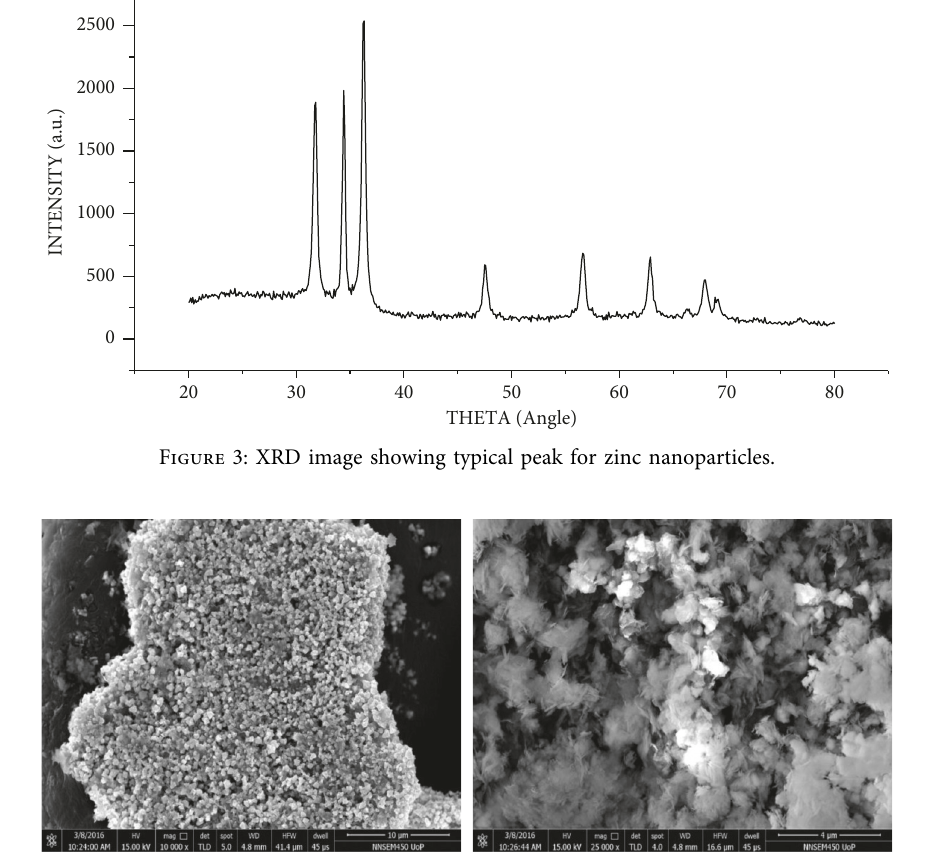
Figure 4: SEM images at different magnifications.